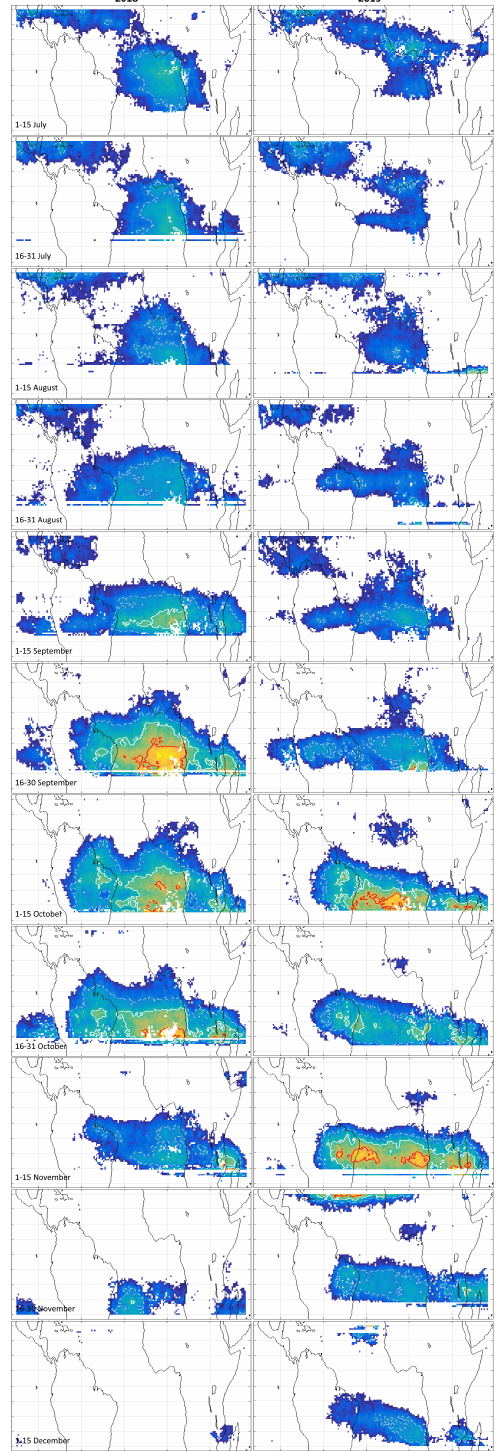
Figure 12. Median 15d TROPOMI TrOC over the Atlantic basin between early July and mid-December (top to bottom) for 2018 (left) and 2019 (right). Grid cells with sparse or inhomogeneous temporal sampling or a value below 30DU are blank. Contours in- dicate the 35DU (dashed), 40DU (solid) and 45DU (red)